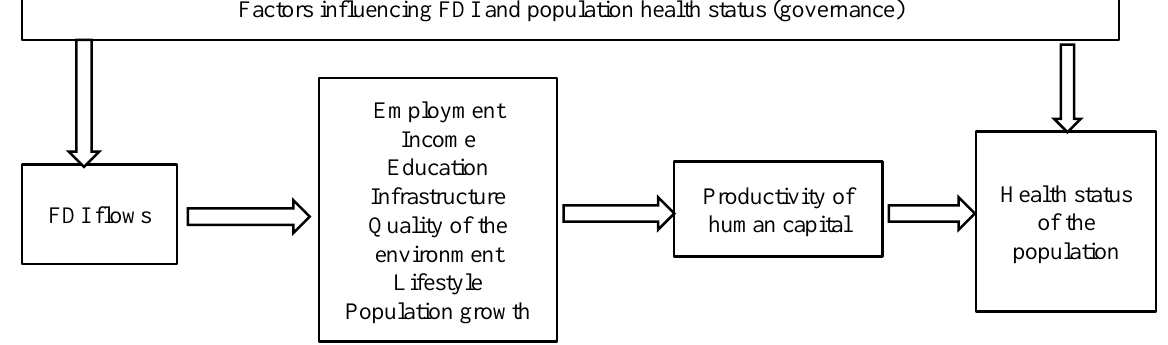
Figure 1: Conceptual framework of the relationship between FDI and population health Source: Author, Adapted from (Immurana,